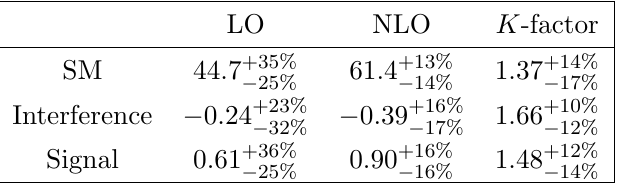
Table 4 . Cross sections for benchmark B in pb with m ( t (cid:22) t ) > 750 GeV. Uncertainties are from renormalisation and factorisation scale variation.